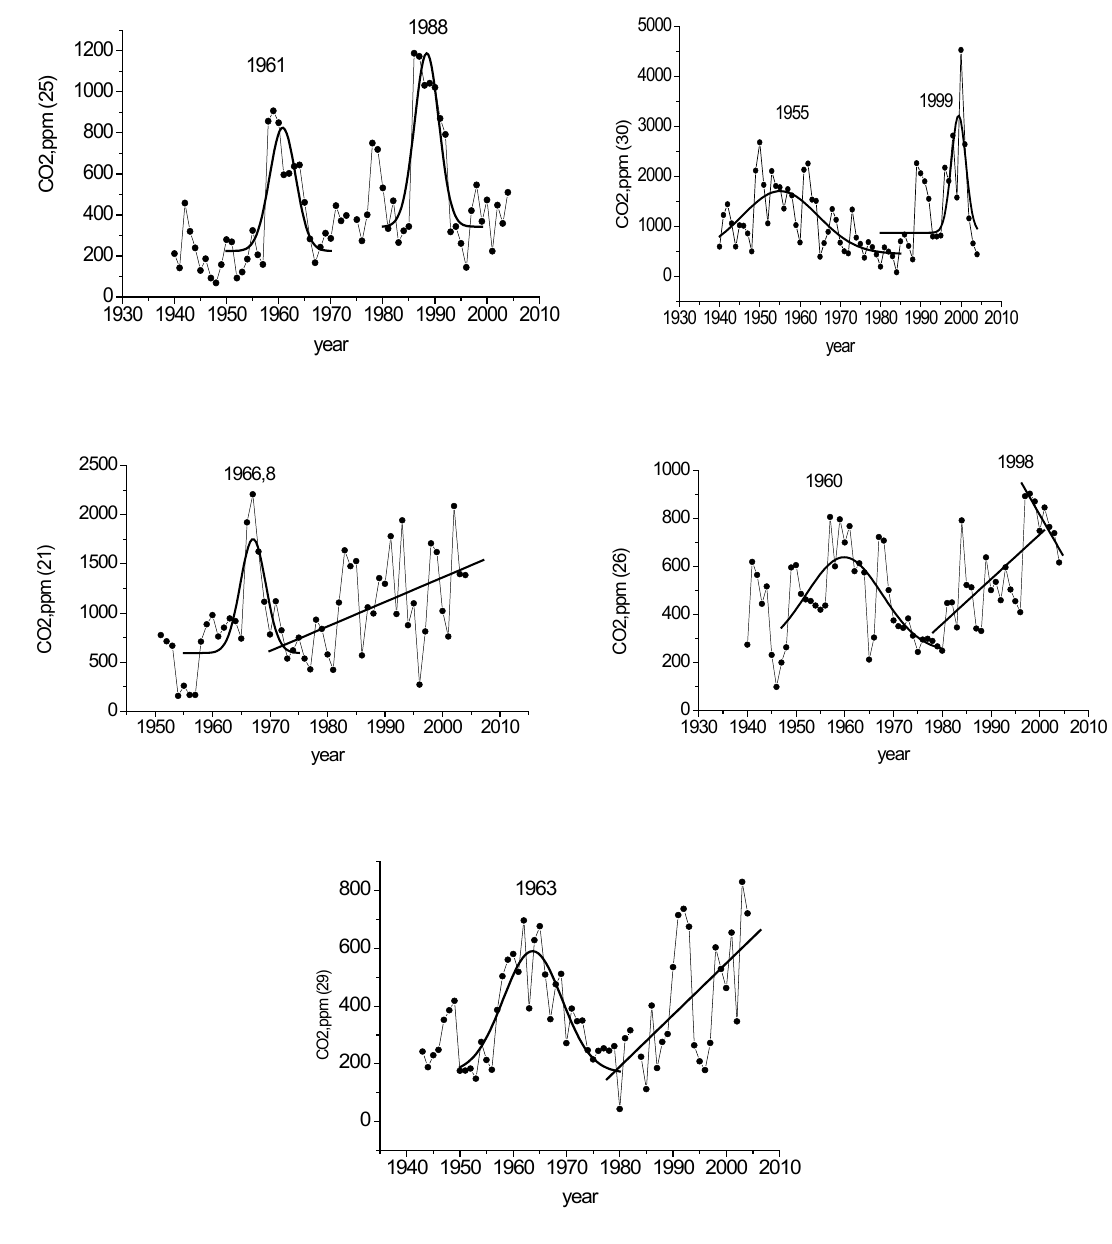
Figure 1. Annual trends of the CO concentration in spruce discs (No. 21, 25, 26, 29, 30) 2 obtained with the use of a Gaussian approximation for identifying a maximum